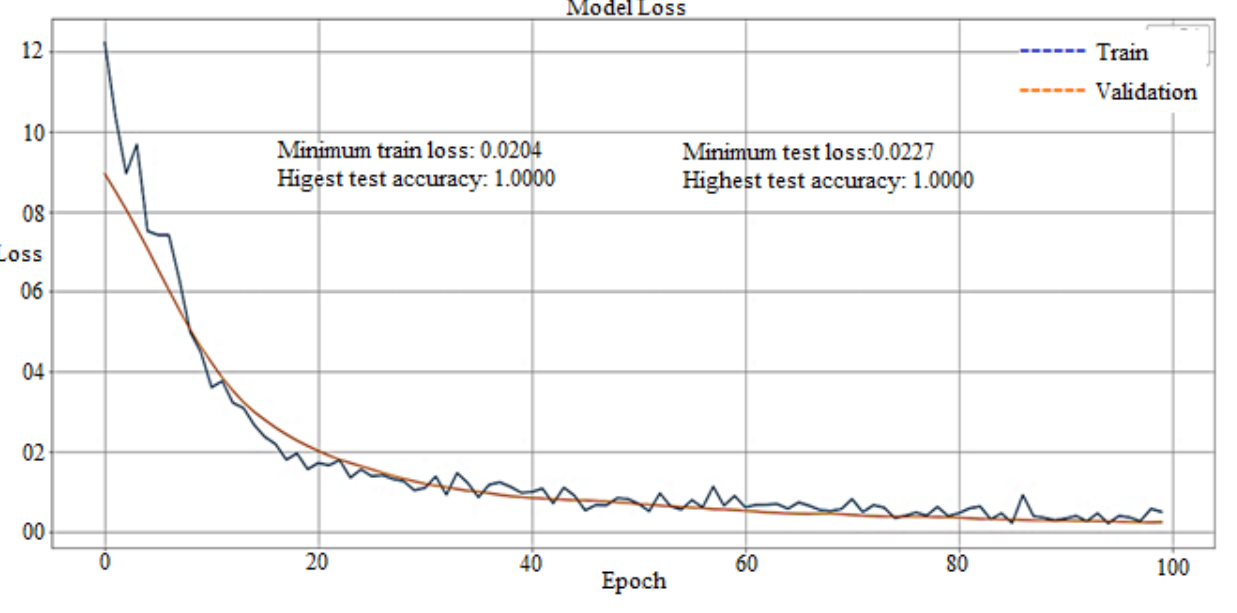
Figure 14. Loss curve of the